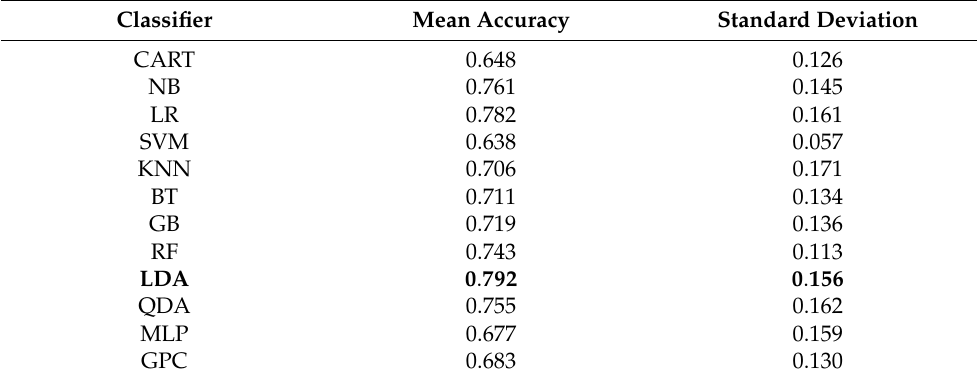
Figure 7. Cross validation results on dataset #3 for the HV level faults. Table 7. Cross validation accuracy and standard deviation for HV dataset